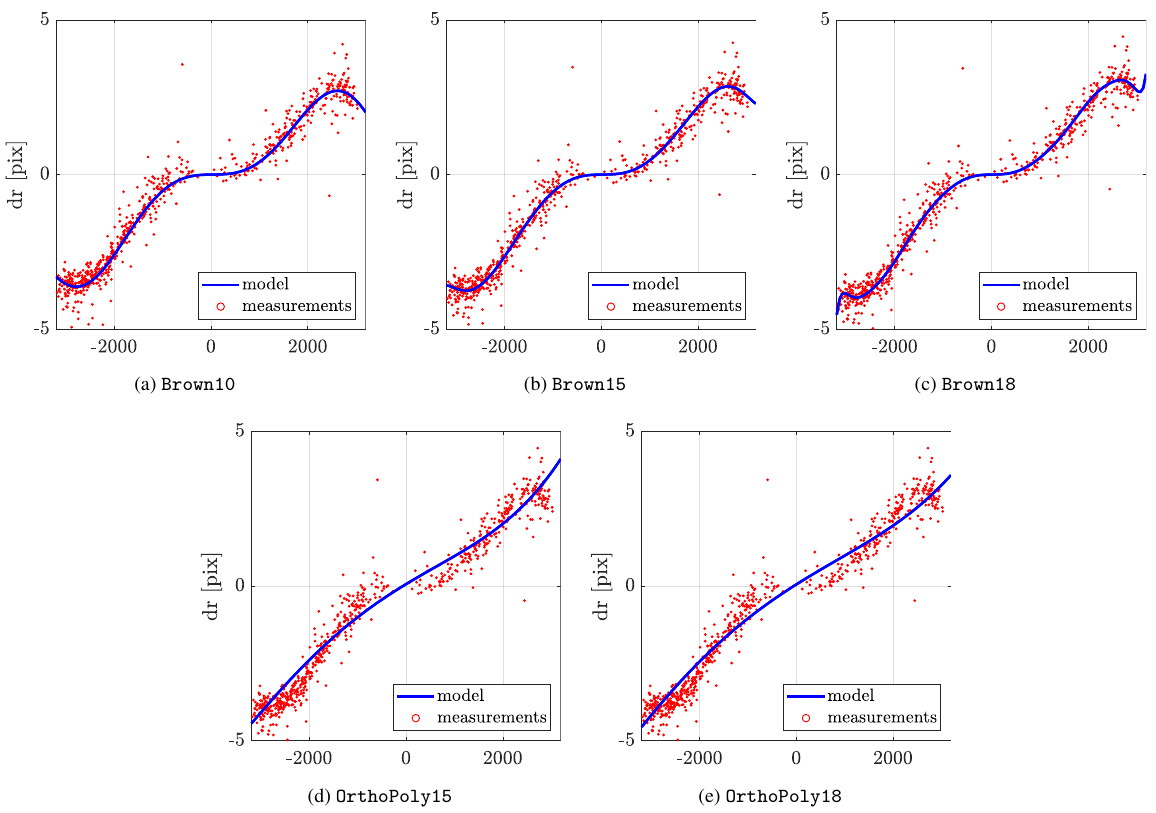
Figure 3. Radial component of the observed departures from collinearity, (cid:126)v P (red dots), and as implied by the estimated IO model, i (cid:126)v M (blue curve), for points on the diagonal of the image plane.